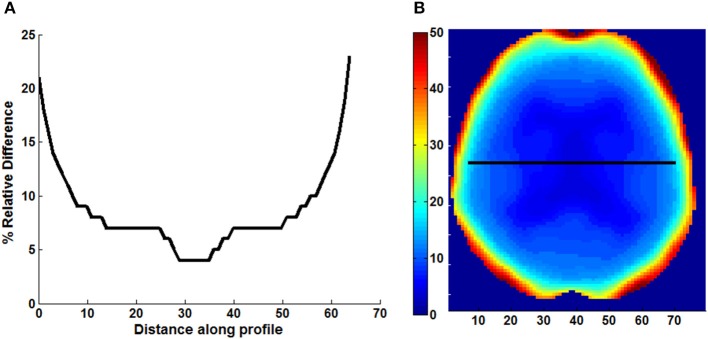
Line profile (A) across the center slice of a map (B) of relative difference (% RD) between PET images reconstructed with Dixon and Dixon+bone μ-maps. Images are presented from a representative subject.